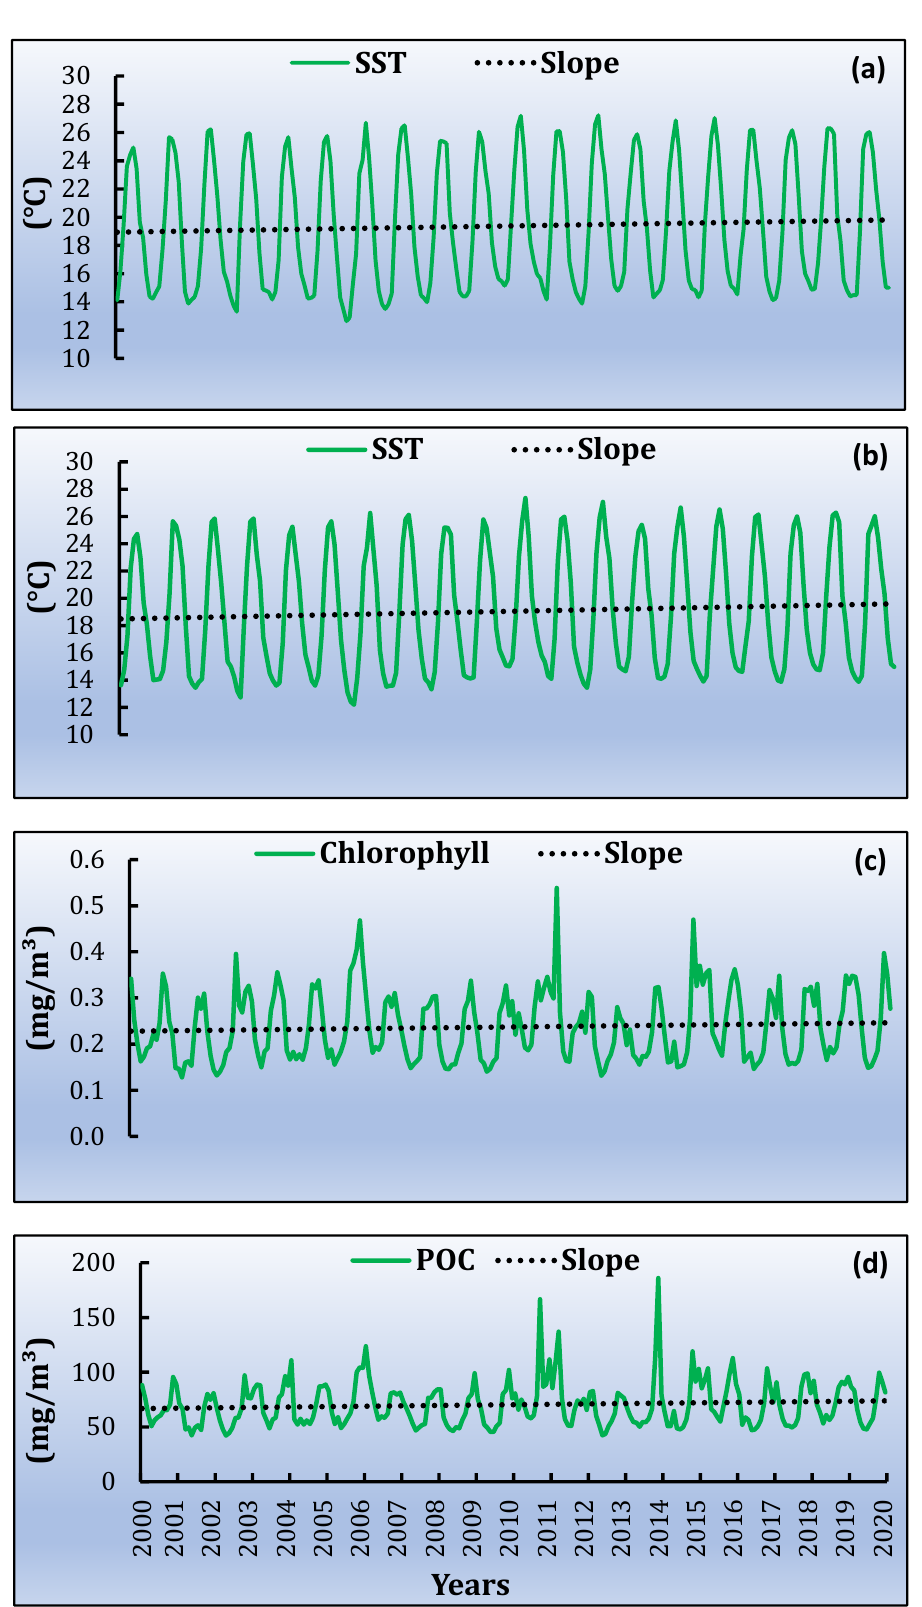
ues are mostly observed in August, during the warm period of July and August, while the lowest values are in February and March, for both daytime and night-time (Figure 5a,b). The mean monthly values of Chl-a concentration range between 0.092 mg/m 3 and 0.879 mg/m 3 , during July 2001 and May 2011, respectively (Figure 5c). POC ranged from 42.184 mg/m 3 to 186.044 mg/m 3 , following almost the same monthly pattern as for Chl-a. The highest concentration of POC was recorded in January 2014 and the lowest in June 2002 (Figure 5d).